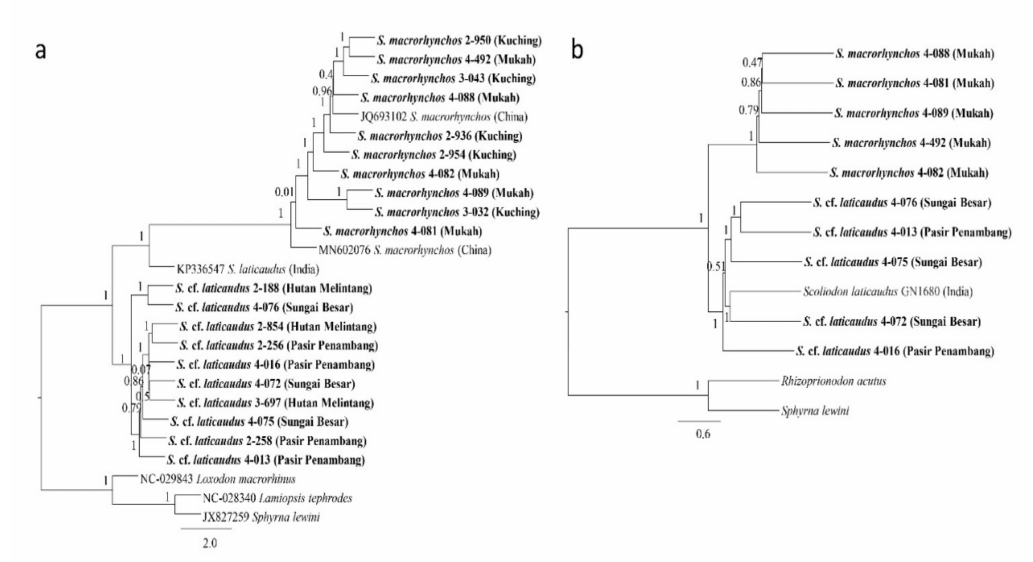
Figure 4. ASTRAL species tree of Scoliodon species for ( a ) mtDNA and ( b ) nuclear